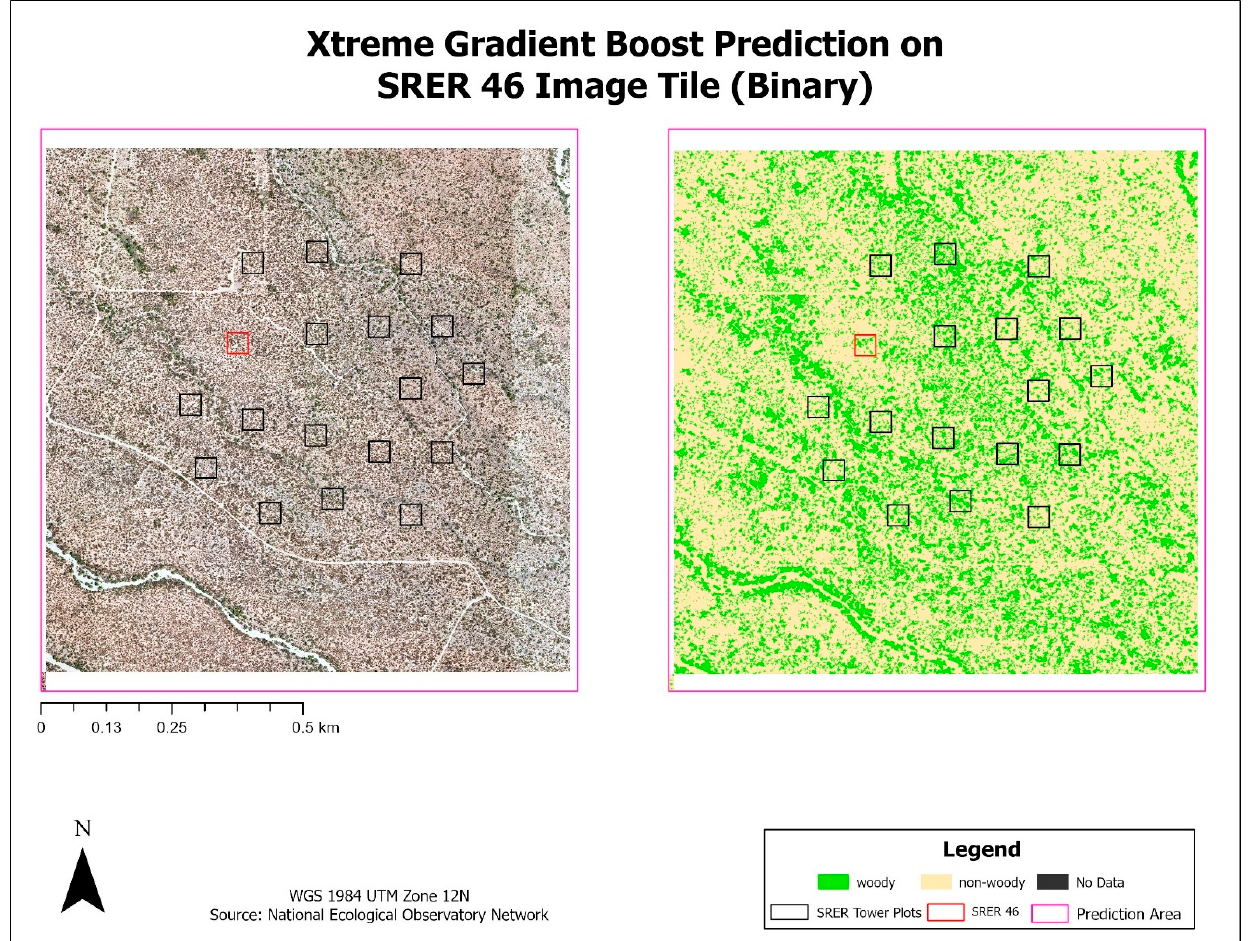
Figure 9. XGB predictions for the Plot 46 image tile using the binary classification scheme. FWC for the entire prediction area is 31.7%. Areas with higher densities of woody plant cover are clearly highlighted in green in both the RGB and prediction tile, along with clear delineation of water and road/trail features.